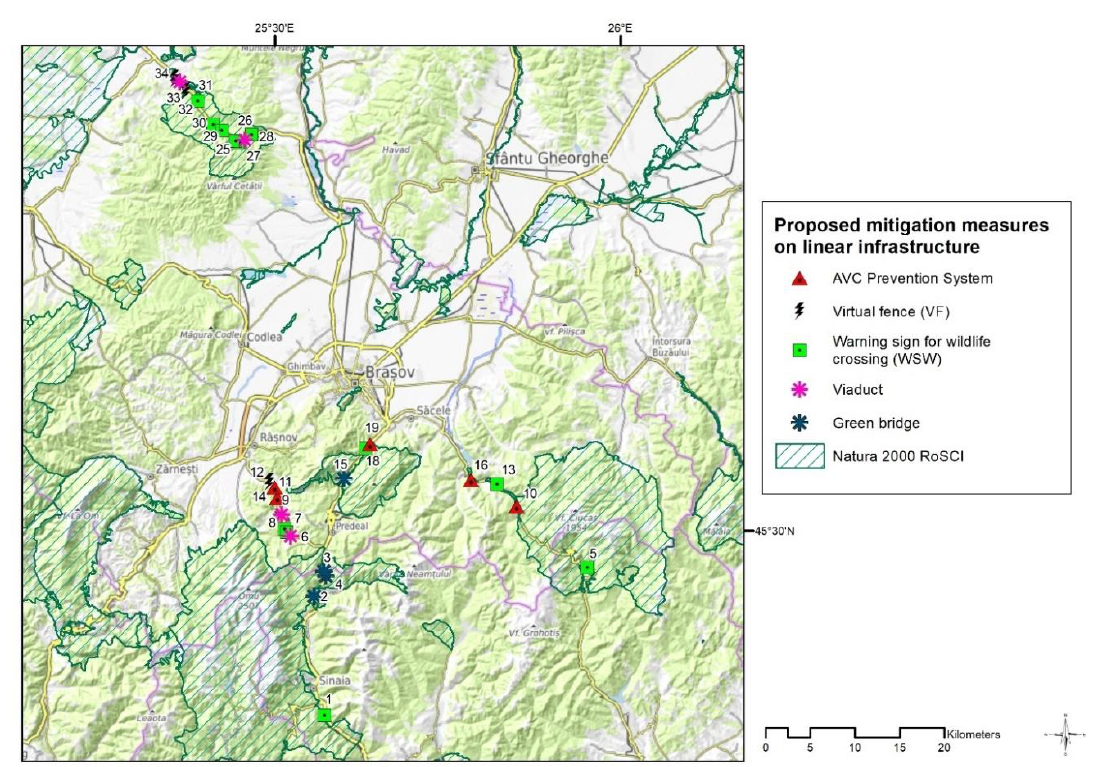
Figure 7. WVC hotspot and the mitigation measures proposed to be included on the planned linear infrastructure.